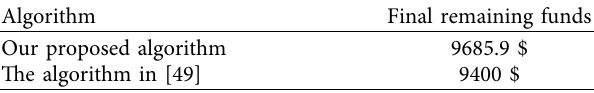
Figure 19: Comparison of two situations in Level 3. Table 10: Comparison of two algorithms in Level